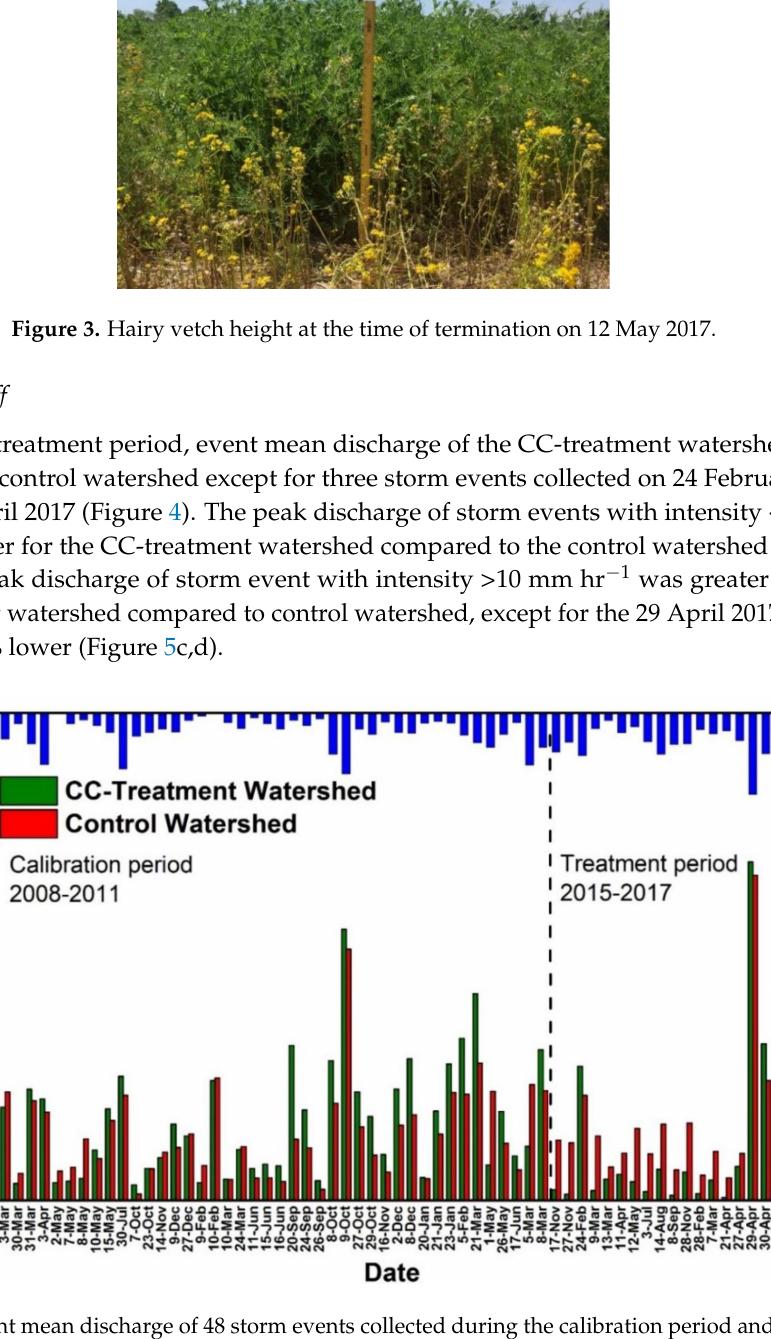
Figure 4. Event mean discharge of 48 storm events collected during the calibration period and 18 storm events collected during the treatment period from the CC-treatment and control